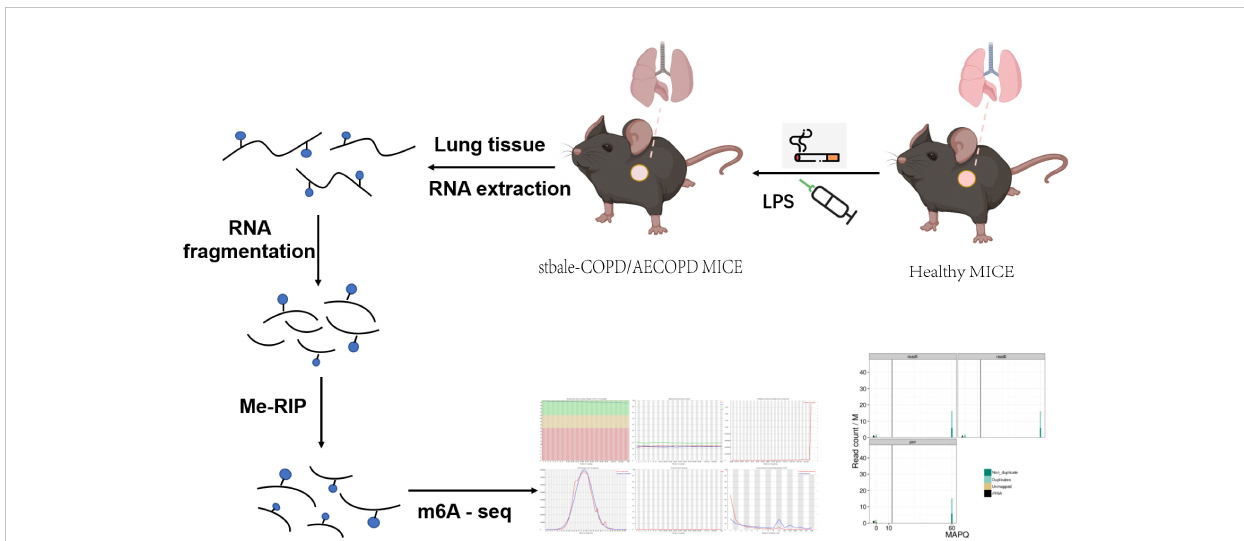
FIGURE 2 Schematic of m6A-seq analysis in C57 mice: C57 mice were stimulated with cigarette smoke or LPS, and their lung tissues were excised and used to extract total RNA. The RNA was fragmented and m6A RNA separated according to Me-RIP analysis. Construction of m6A-seq library and sequencing for analysis.